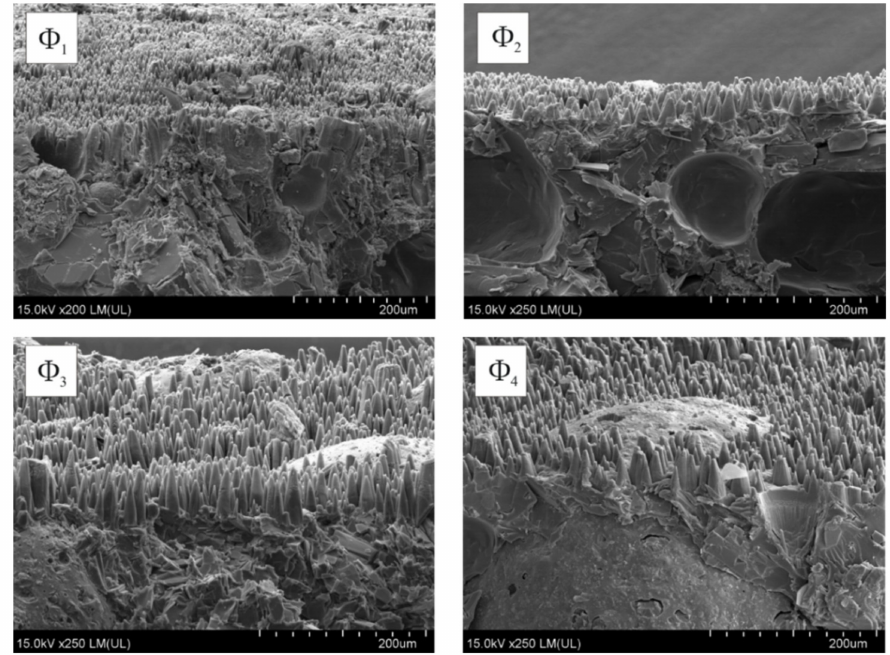
Figure 6. SEM images of laser irradiated (N = 500, E j = 100 mJ/cm 2 ) coatings containing glass microspheres: Φ 1 , Φ 2 , Φ 3 and Φ 4